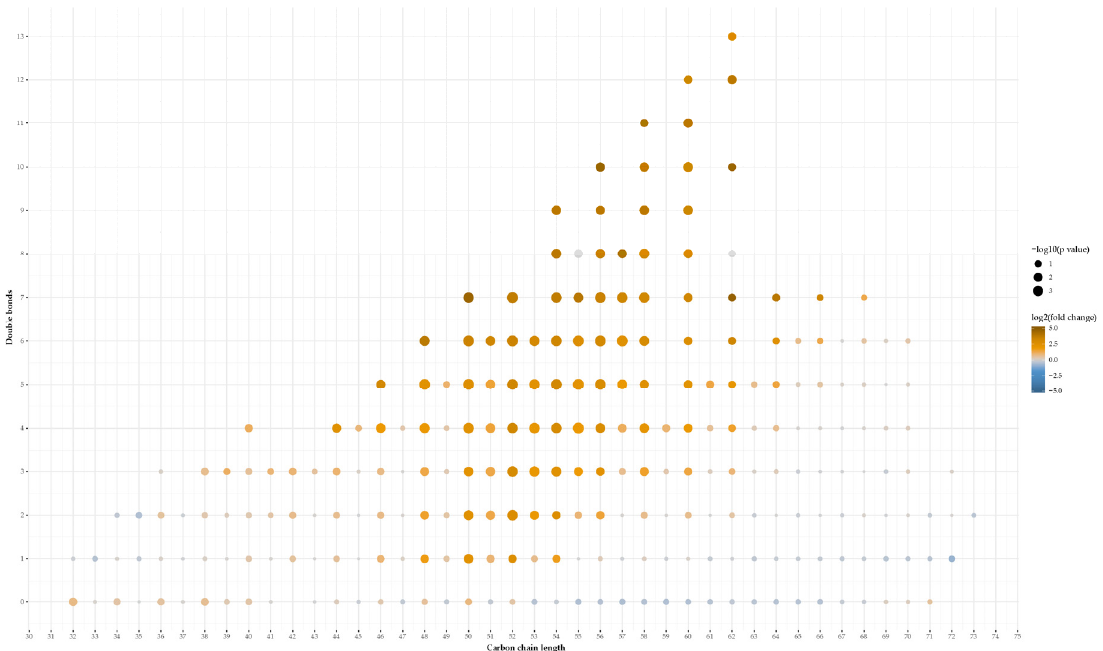
Figure 5. Plot (carbon chain length versus double bounds) of the triglyceride species found in gallbladder bile from bariatric gallstone patients compared to nonbariatric gallstone patients. Significance (-log10( p -value)) and effect size (log2(fold change)) are shown in the legend.